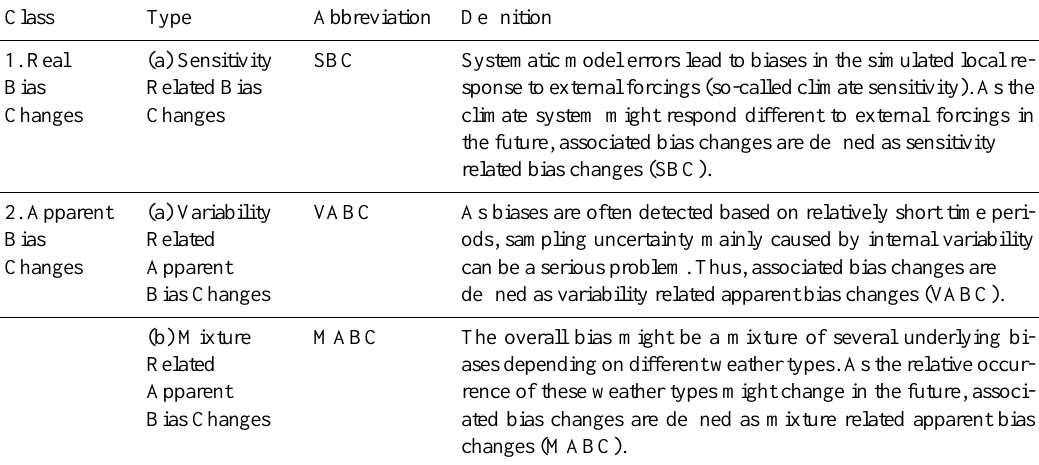
Table 1. Classification and definitions of different bias changes based on Maraun (2012).